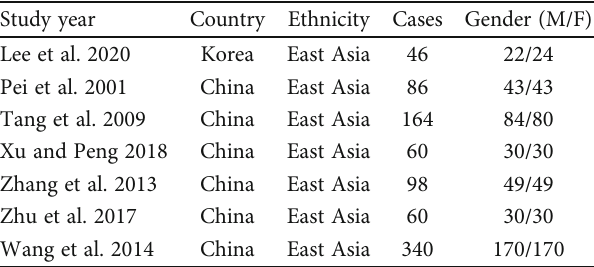
Figure 1: Characteristics of the studies that were included. Table 1: Included studies basic